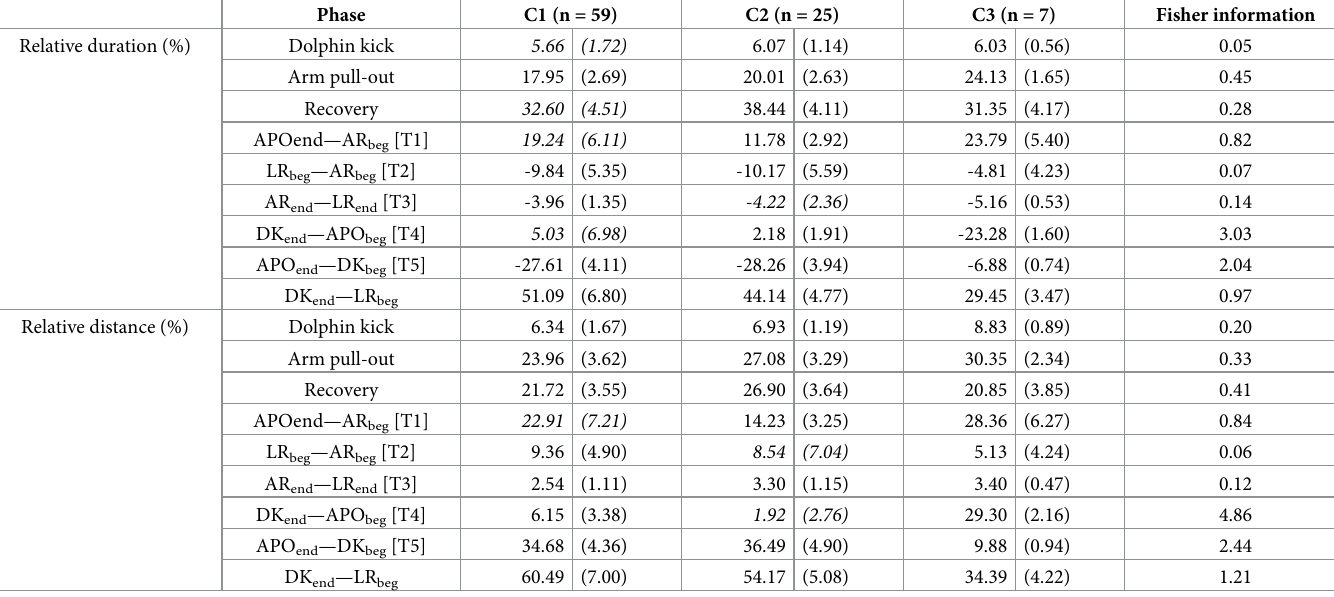
Table 3. Mean (SD) relative time and displacement of the active underwater phases in each cluster and Fisher information of each variable.